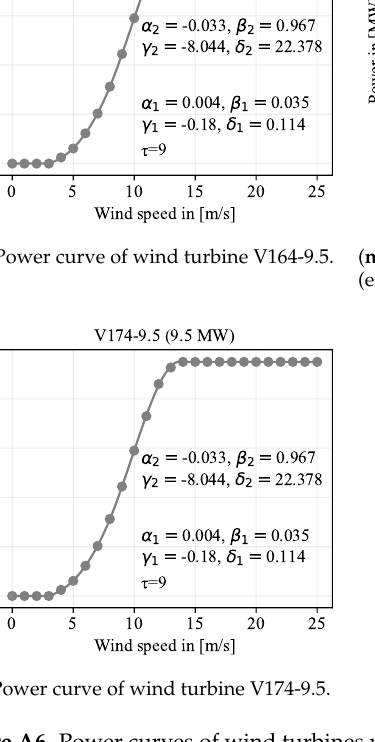
Figure A6. Power curves of wind turbines used in the